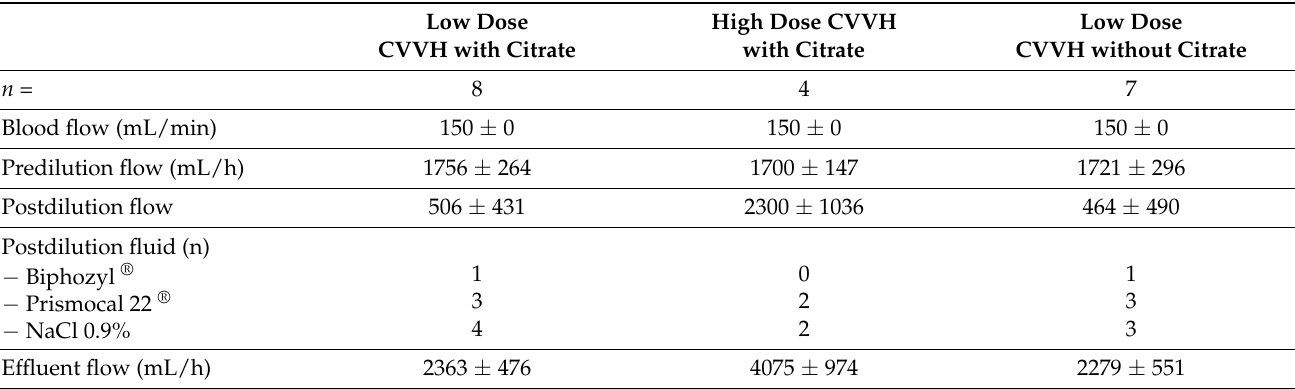
Table 2. Continuous venovenous hemofiltration (CVVH)